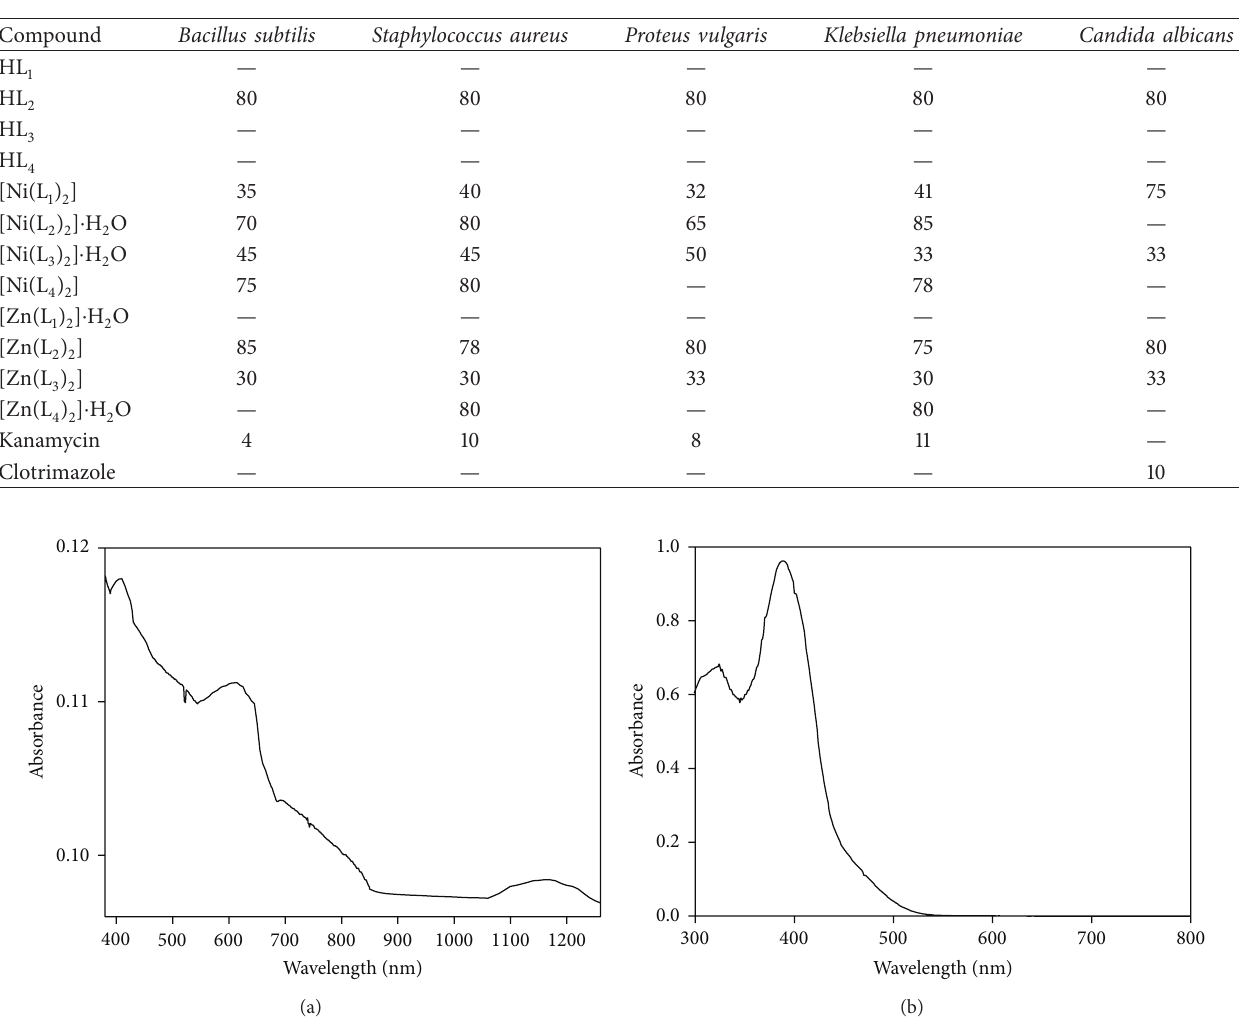
Figure 2: Electronic spectra of (a) [Ni(L 4 ) 2 ] and (b) [Zn(L 4 ) 2 ] ⋅ H 2 O.